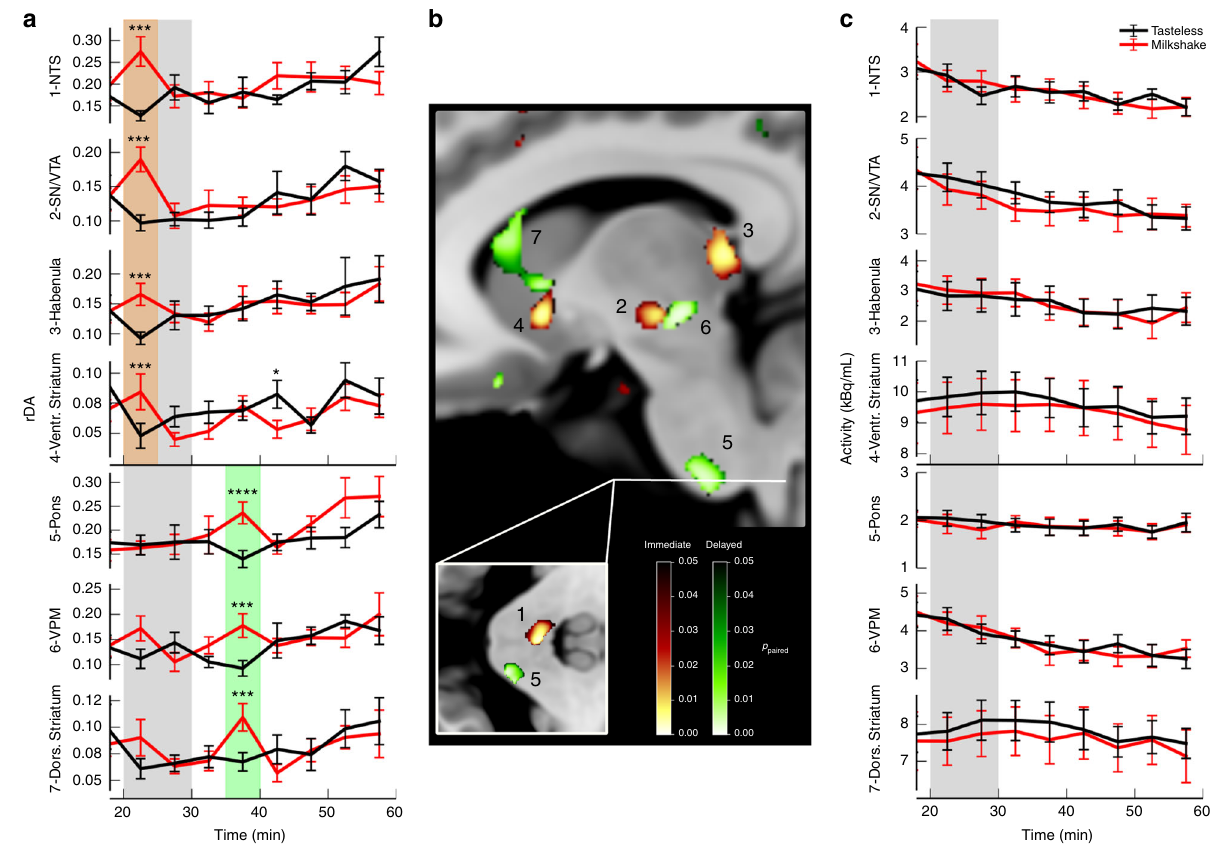
Fig. 10 Food-induced DA release in humans. During two separate PET imaging sessions human volunteers ( n = 10) received either a tasty milkshake or a tasteless solution starting 20 min after [11C]raclopride injection for 10 min. a Time course of rDA in regions with signi fi cant differences between milkshake (red) and tasteless (black) condition in the 20 – 25 min (orange box) or 35 – 40 min (green box) time interval. The gray box indicates the time of milkshake/ tasteless solution administration. b Locations of regions with signi fi cant differences of rDA between milkshake and tasteless condition in the 20 – 25 min (red color scale) or 35 – 40 min (green color scale) time interval. c Time activity curves in the regions indicated in ( b ) showing no detectable differences between the tasteless and milkshake condition. Identi fi ed regions are 1: nucleus of the solitary tract (NTS), 2: substantia nigra/VTA, 3: habenula, 4: ventral striatum, 5: pons, 6: ventral posterior medial nucleus of the thalamus (VPM), and 7: dorsal striatum. All data are represented as mean±SEM,